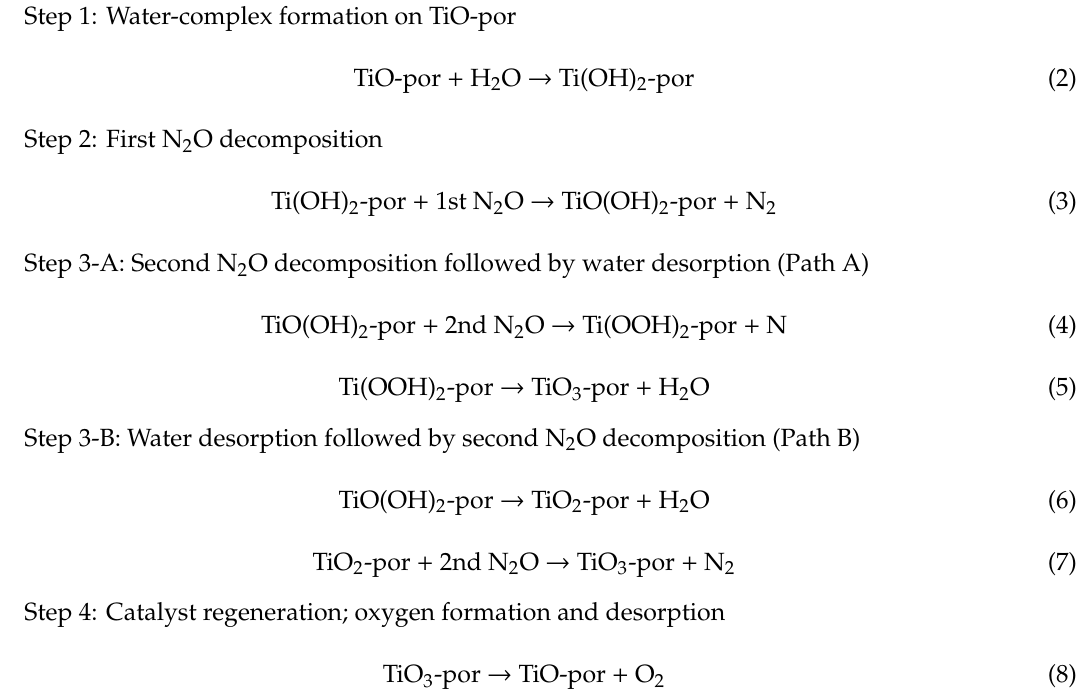
Figure 1. Structure of oxotitanium(IV) porphyrin (TiO-por).